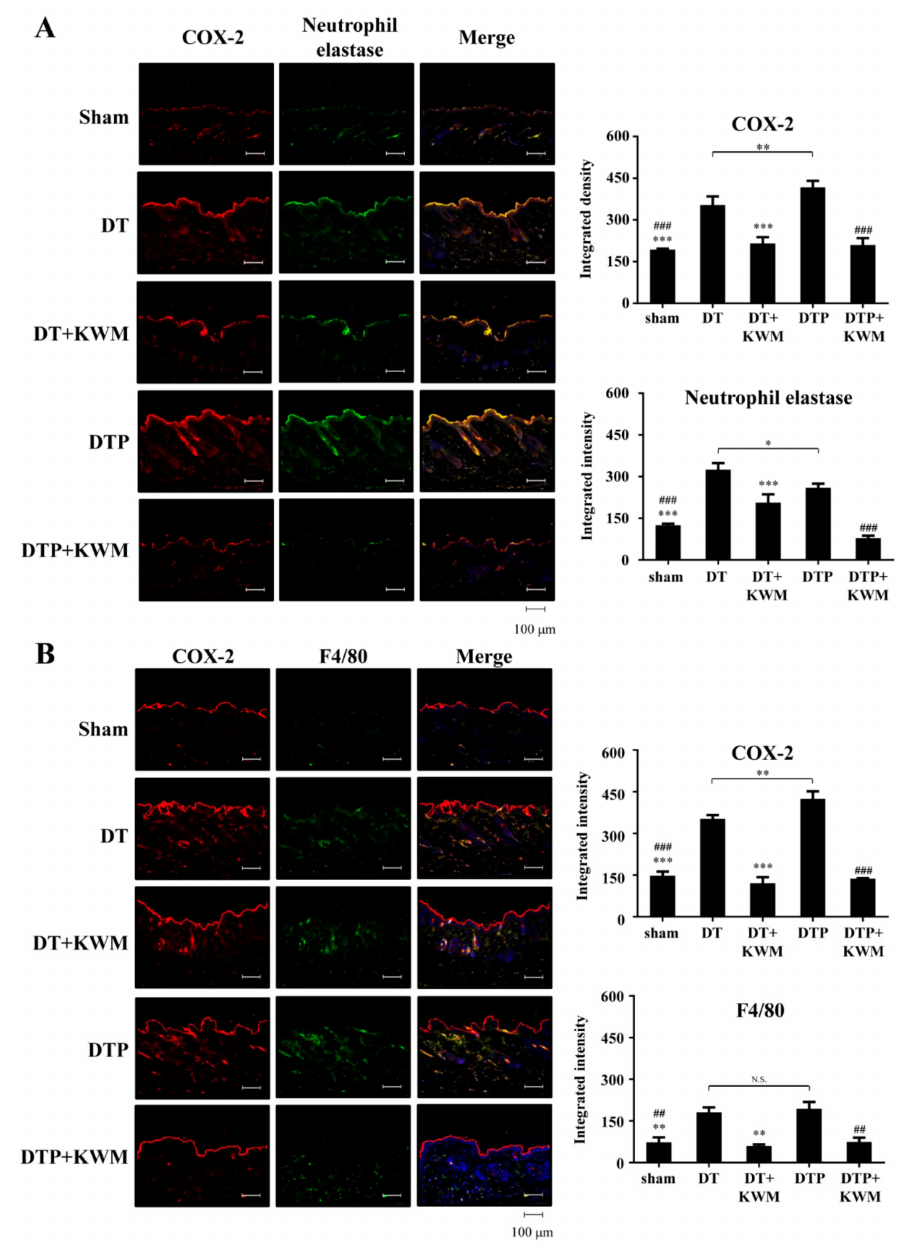
Figure 5. Effect of KWM-EO on the inflammatory immune system in skin tissue from the mice two-stage skin carcinogenesis. Immunofluorescent staining of inflammatory mediator COX-2 (red) with neutrophil elastase (green) ( A ) and macrophage marker, F4 / 80 (green) ( B ). Nuclei were counterstained with DAPI (blue). Representative images are shown. The data are representative of three independent experiments and are expressed as mean ± SD. N.S. means non significance; P * < 0.05, P ** < 0.01, P *** < 0.001 compared to DT group; P ## < 0.01, P ### < 0.001 compared to DTP group (ANOVA). Scale bar: 100 µ